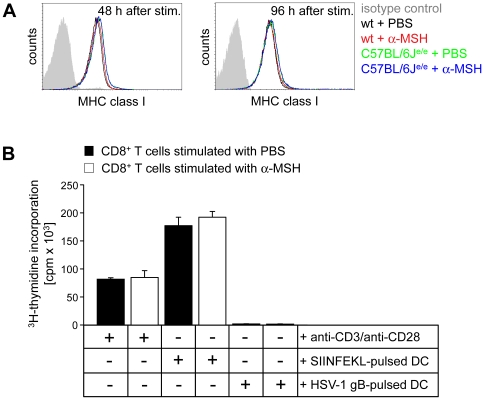
Alpha-MSH does not influence MHC I expression in CD8+ T cells or the capacity to recognize antigens.(A) Flow cytometric analysis of CD8+ T cells from wt or C57BL/6Je/e mice (n = 5 mice each group) after stimulation with α-MSH (10−9 molar) for 48 h or 96 h. Cells were gated for CD8 and MHC class I expression is shown in a representative histogram overlay. (B) PBS and α-MSH stimulated CD8+ T cells from OT-1 mice equally recognize the relevant antigen presented by DC. BmDC were pulsed with SIINFEKL or HSV-1 gB peptides and co-cultured with PBS or α-MSH stimulated CD8+ T cells from OT-1 mice for 3 days (DC/T cell ratio  = 1/40). Subsequently, T cell proliferation was assessed by 3H-thymidine incorporation. One representative experiment out of three is shown.